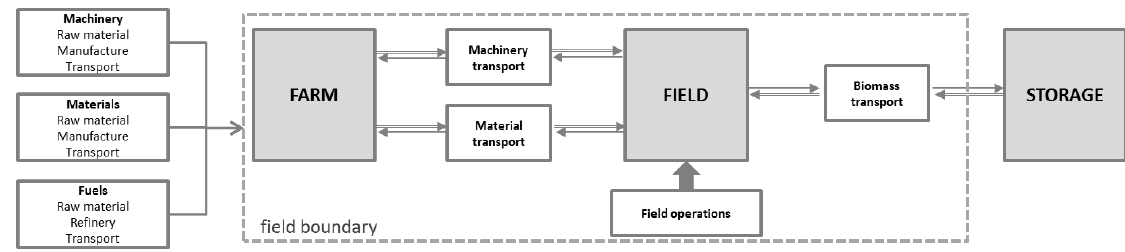
Figure 1. System boundaries of the energy inputs.